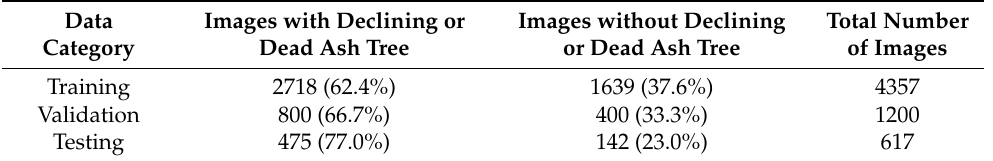
Table 1. Data used for developing deep learning models including training, validation, and test- ing